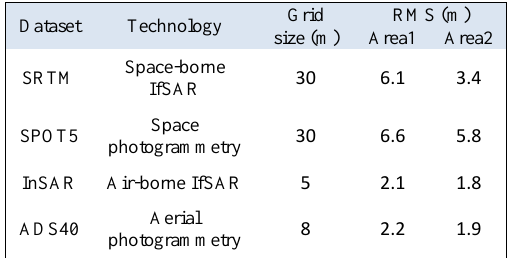
Figure 5. (a) Outline of the two test areas; with corresponding LiDAR DEMs displayed in (b) and (c). Table 1. Target DEMs, with resolution and representative vertical accuracy (RMS) compared to LiDAR reference